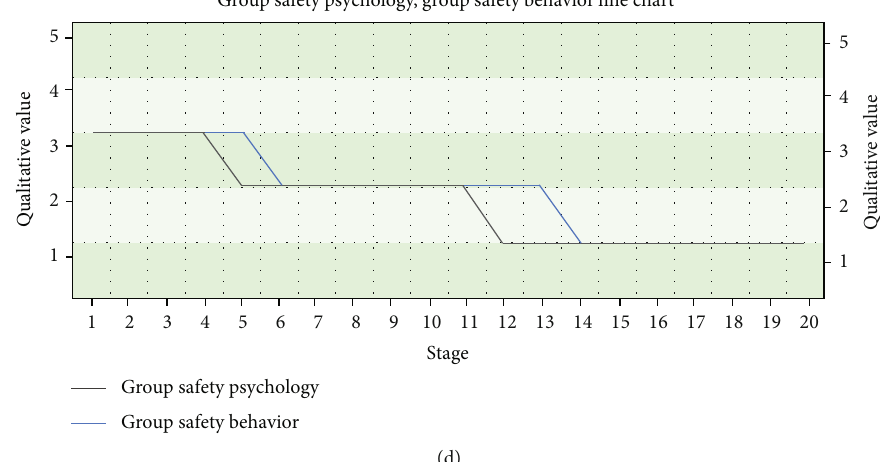
Figure 9: Simulation results and comparative analysis diagram of Scheme 1. (a) Simulation result statistics. (b) Trend chart of group safety psychological change. (c) Trend plot of group safety behavior change. (d) Plot of comparison of trends in group safety psychology and behavior